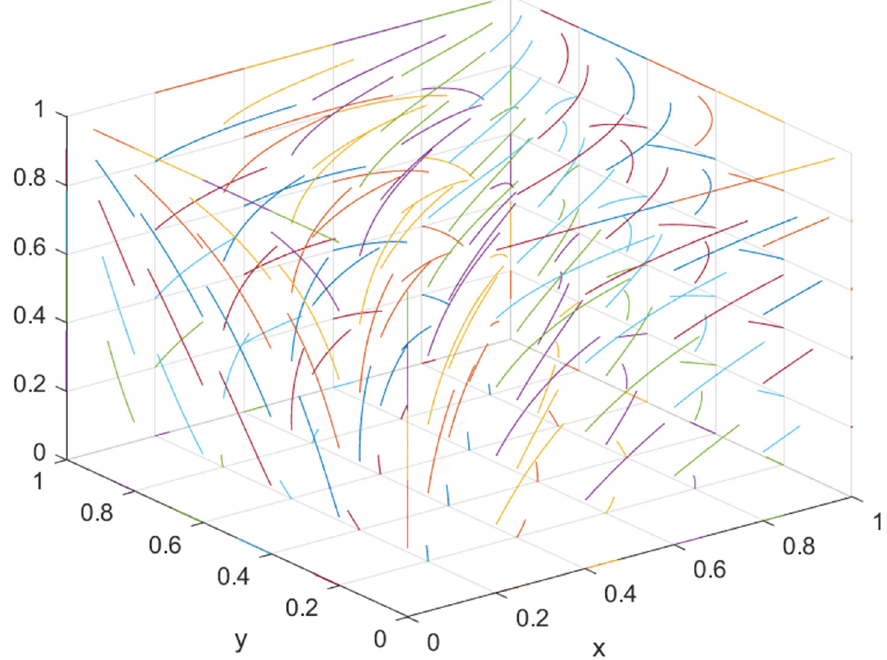
Figure 8. Evolution of developers, general contractors and governments. Parameters: 𝑥 (cid:3404) 0.5, 𝜃 (cid:3404) 0.4, 𝐼 (cid:2869) (cid:3404) 10, 𝐼 (cid:2870) (cid:3404) 8, 𝐶 (cid:2869) (cid:3404) 3.5, 𝐶 (cid:2870) (cid:3404) 2.5, 𝐸 (cid:2869) (cid:3404) 3, 𝐸 (cid:2870) (cid:3404) 3, 𝐸 (cid:2871) (cid:3404) 1.8, 𝐸 (cid:2872) (cid:3404) 1.3, 𝐷 (cid:2869) (cid:3404) 1.3, 𝐷 (cid:2870) (cid:3404) 1.8, 𝑆 (cid:2869) (cid:3404) 0.01, 𝑆 (cid:2870) (cid:3404) 0.01, 𝐹 (cid:2869) (cid:3404) 1.5, and 𝐹 (cid:2870) (cid:3404) 0.65 .